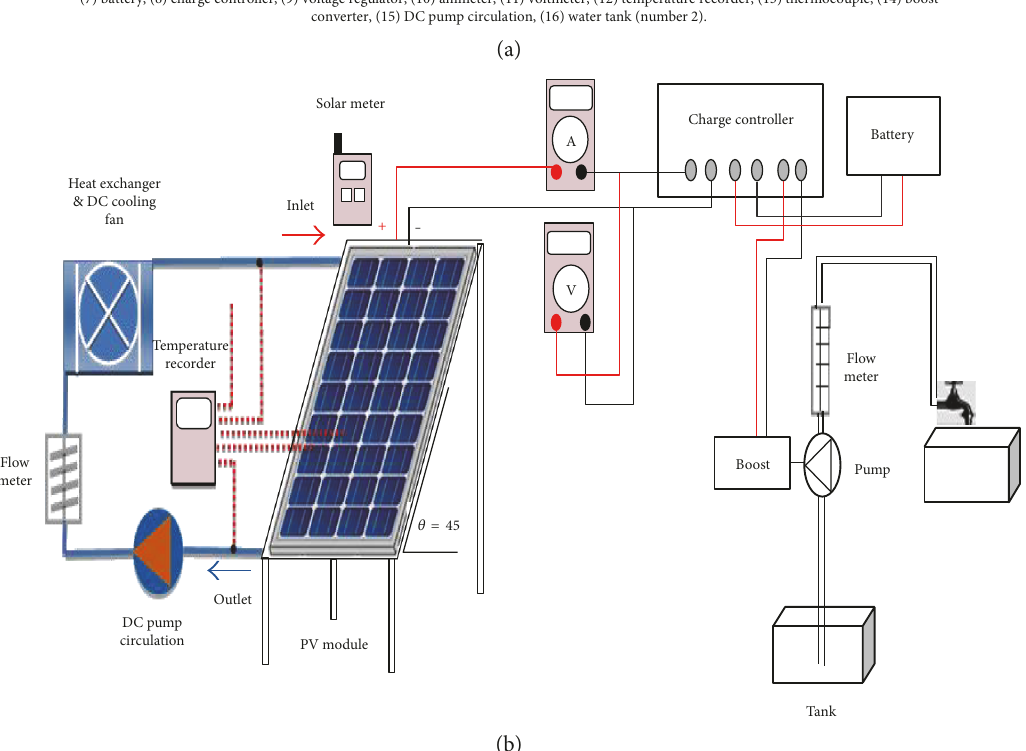
Figure 1: Photograph (a) and schematic diagram (b) of the experimental